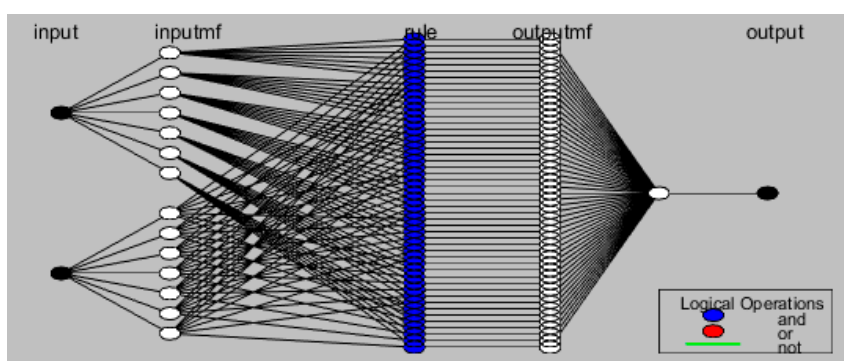
Figure 6. Simplified schema of model local model NFM 1.